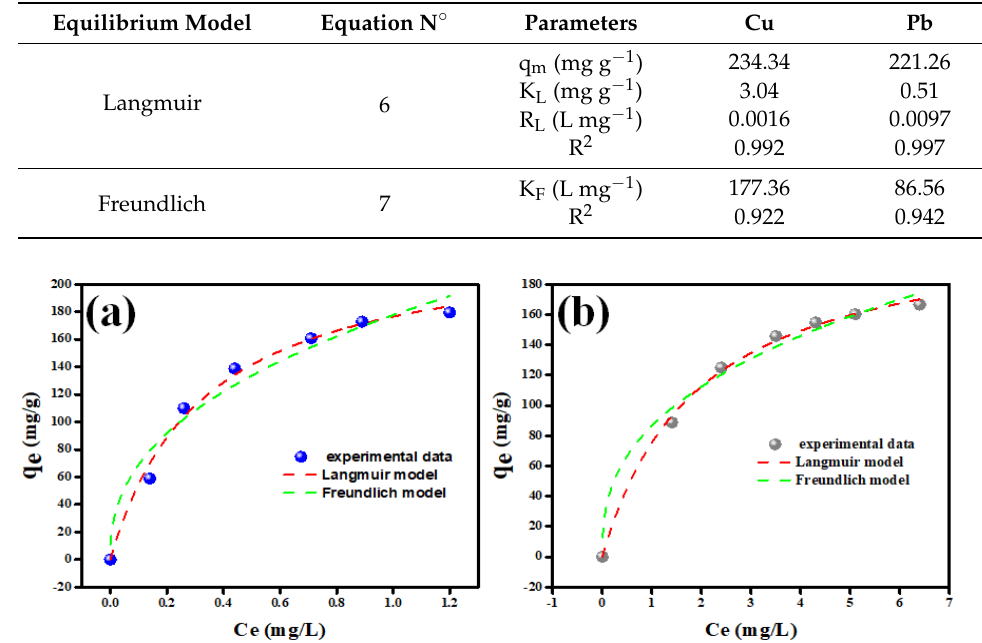
Figure 7. Nonlinear Cu(II) ( a ) and Pb(II) ( b ) equilibrium adsorption isotherms onto MgO nanopar– ticles fitted with Freundlich and Langmuir model.